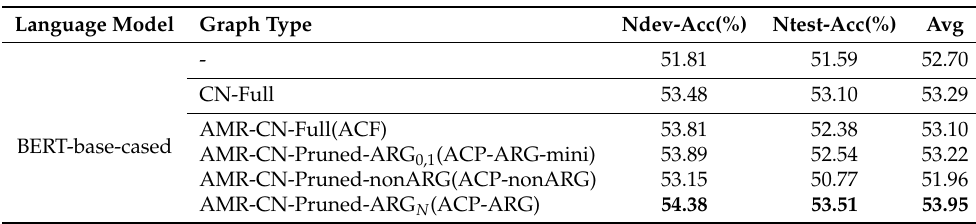
Table 2. Experiments on diverse graph